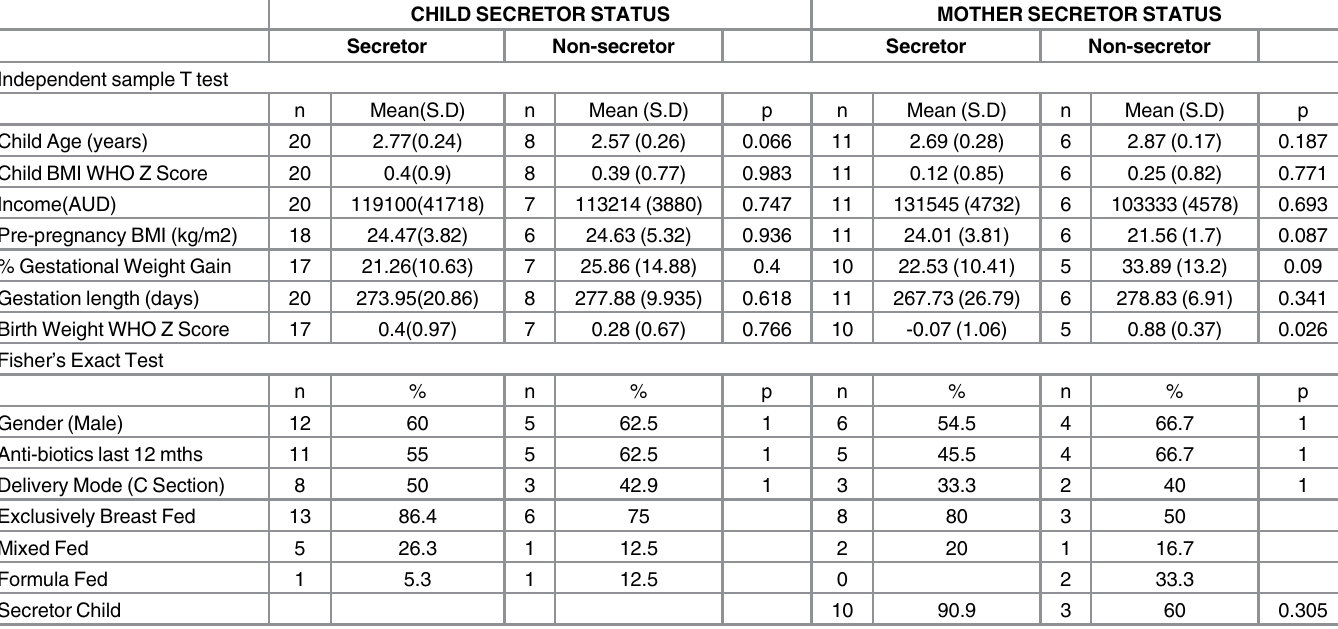
Table 1. Participant characteristics by child and mother secretor